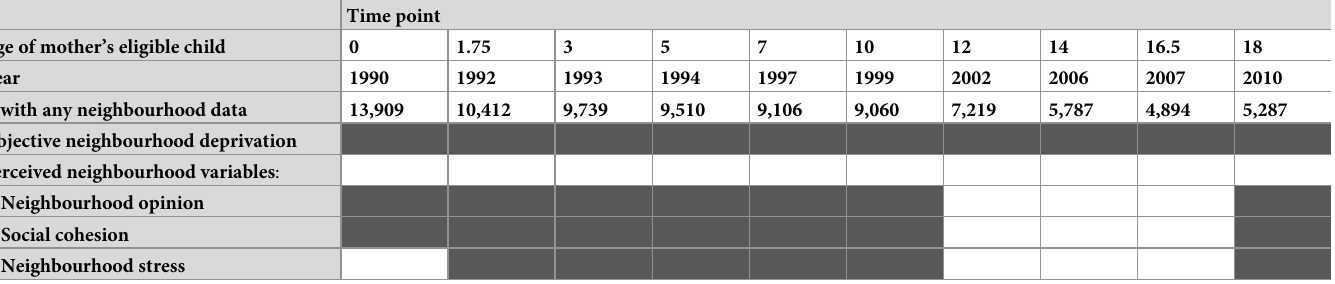
Shaded box indicates variable was measured at time point